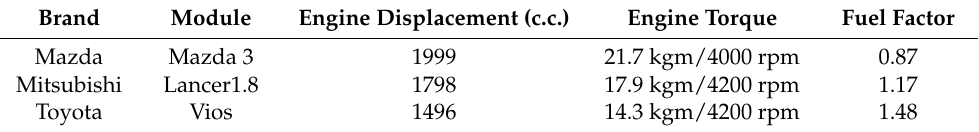
Table 1. Experimental vehicle data.